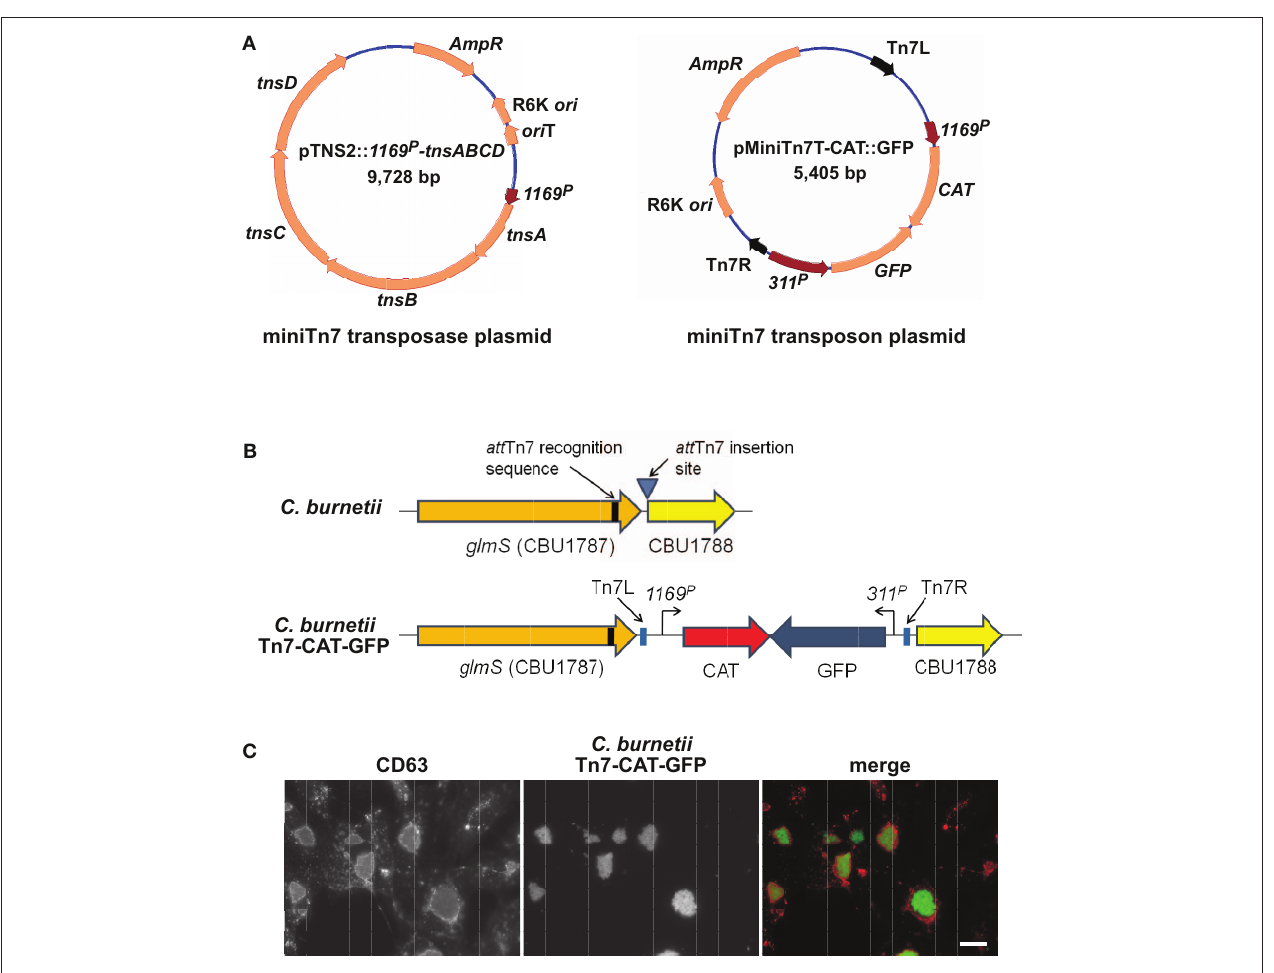
by Tn7L and Tn7R elements. (B) Schematic of the glmS regions in C. burnetii Nine Mile (phase II) and C. burnetii Nine Mile (phase II)/Tn7-CAT-GFP. (C) Fluorescence microscopy of Vero cells infected for 5 days with C. burnetii Nine Mile (phase II)/Tn7-CAT-GFP (green). Cells were fixed with 4% paraformaldehyde, then immunostained for the lysosomal protein CD63 (red). Bar, 5